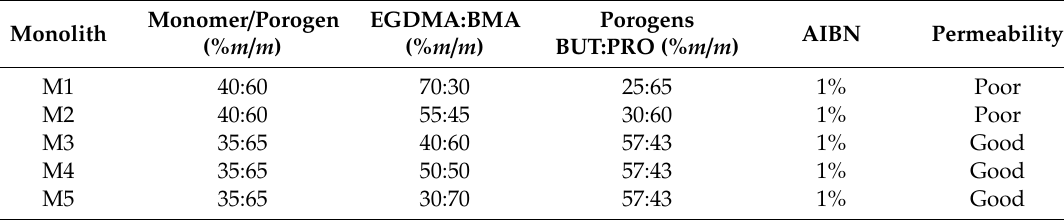
Table 1. Optimization of the organic poly(butyl methacrylate-co-ethylene glycol dimethacrylate) monolith capillary synthesis